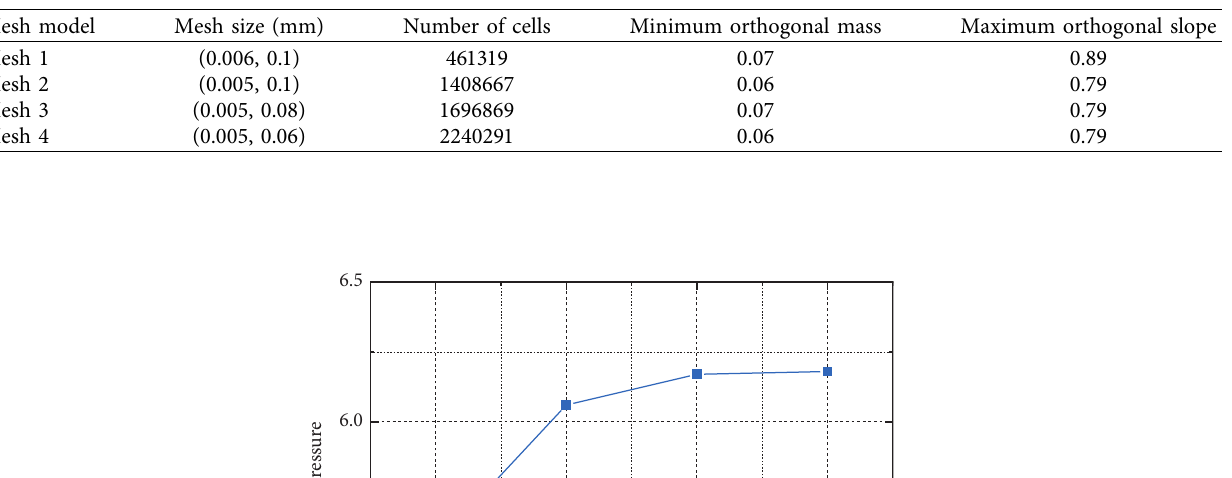
Figure 4: Mesh of the prestage. Table 1: Information of the mesh scheme.